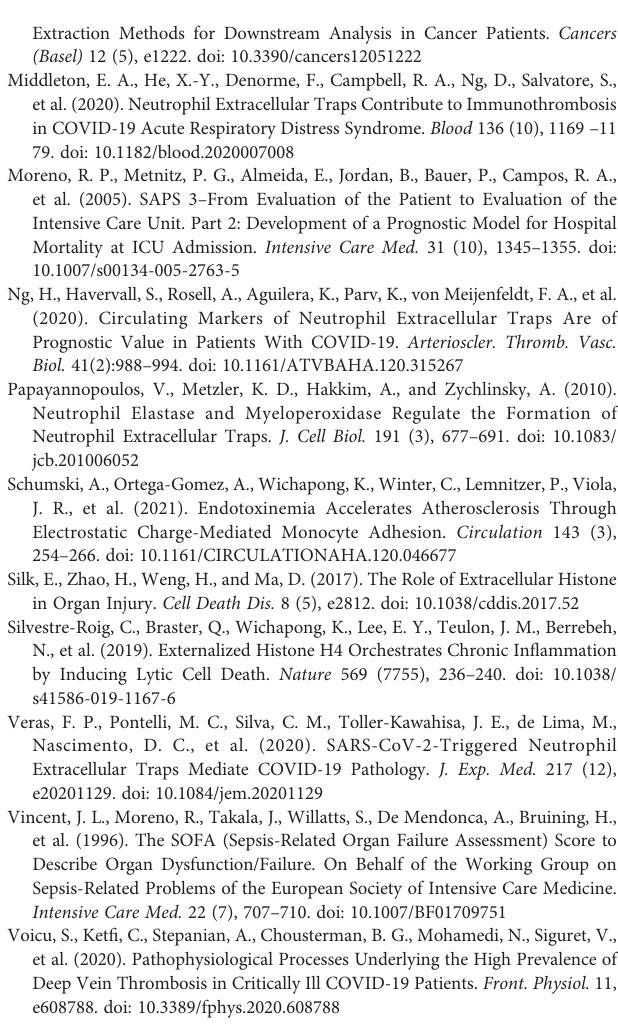
Supplementary Table 1 | Demographic and baseline characteristics of 128 patients on admission to the Intensive care unit. Values are represented as median (IQR) or n (%). Supplementary Table 2 | Events during stay at the ICU for COVID-19 ICU patients, divided by histone H3 status. The number (%) of events for each group is calculated based on the group column